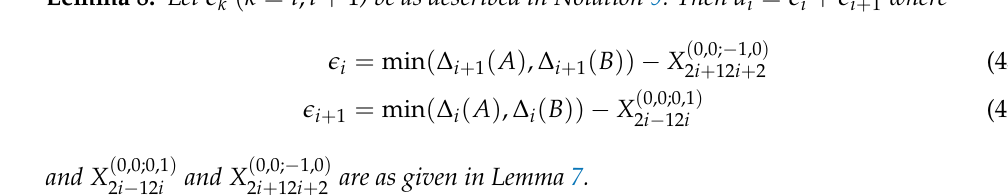
( 0,0; 1,0 ) and X ( 0,0;0,1 ) − 2 i + 12 i + 2 2 i 12 i −